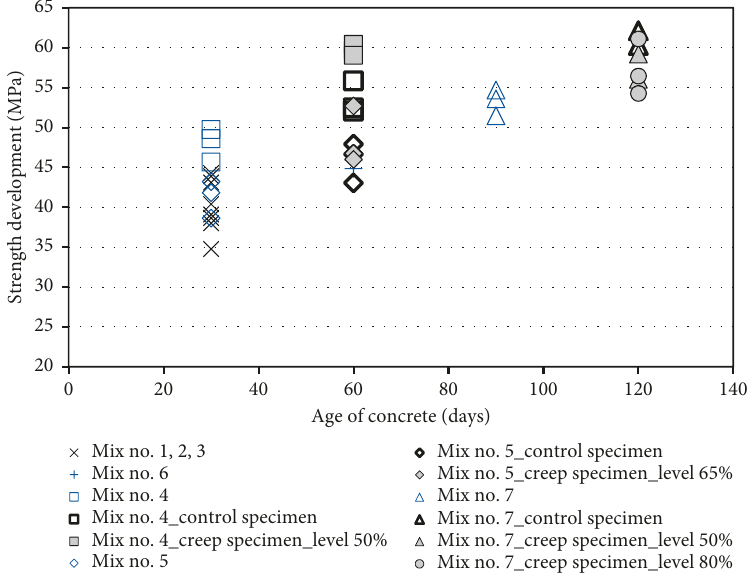
Figure 9: Compressive strength development of unloaded specimens and creep specimens (after 1 month of sustained load applied at ages of 1month and 3months) vs. concrete age (Mix nos. 1, 2, and 3 were generated to investigate the effect of quasi-instantaneous compressive preloading (at levels of 80%, 90%, and 95%, respectively) on tensile strength. Mix no. 6 was produced to study the impact of compressive creep on tensile strength. The influence of compressive creep on compressive strength was assessed by casting mix nos. 4 and 5 for a 1-month loading age (levels of 50% and 65%, respectively) and by introducing mix no. 7, with the load being placed at an age of 3months (for both, 50% and 80% loading levels)).